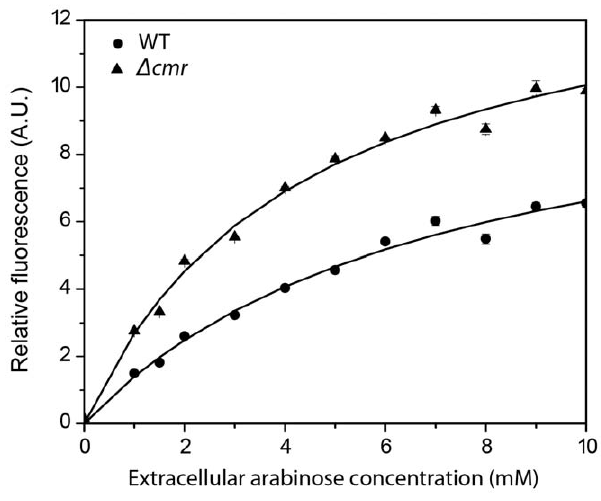
Figure 1. Dose-response curve for the D cmr mutant. P araB - venus in WT and D cmr mutant strains were measured for fluorescence and the results are reported as Fluorescence/OD 600 . Strains were induced with arabinose concentrations varying from 0 mM to 10